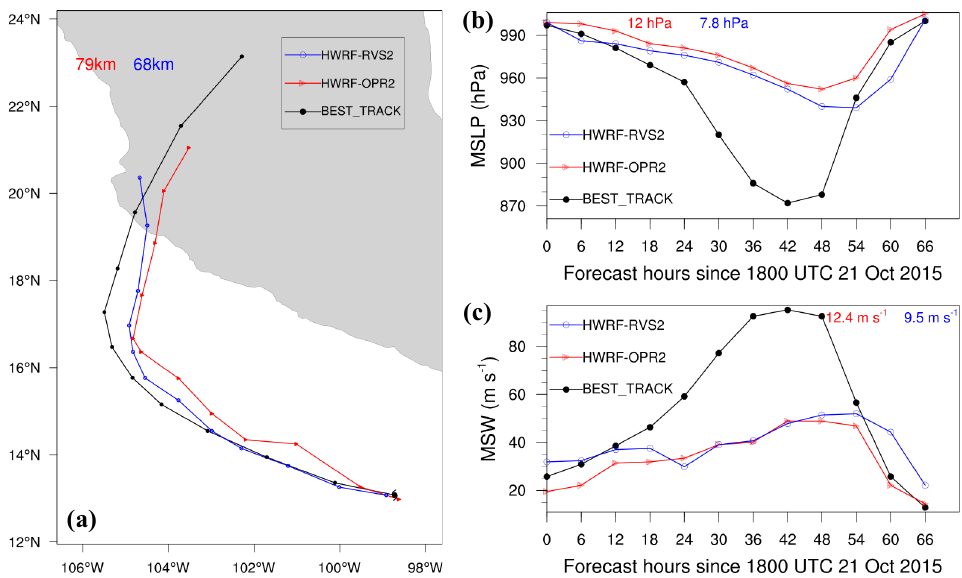
Figure 12. Time series (at 6-h intervals) of ( a ) track, ( b ) minimum sea level pressure (MSLP, hPa) and ( c ) The colored numbers on the top of figures represent the average track ( a ), MSLP ( b ) and MSW ( c ) errors over the first 24-h forecast